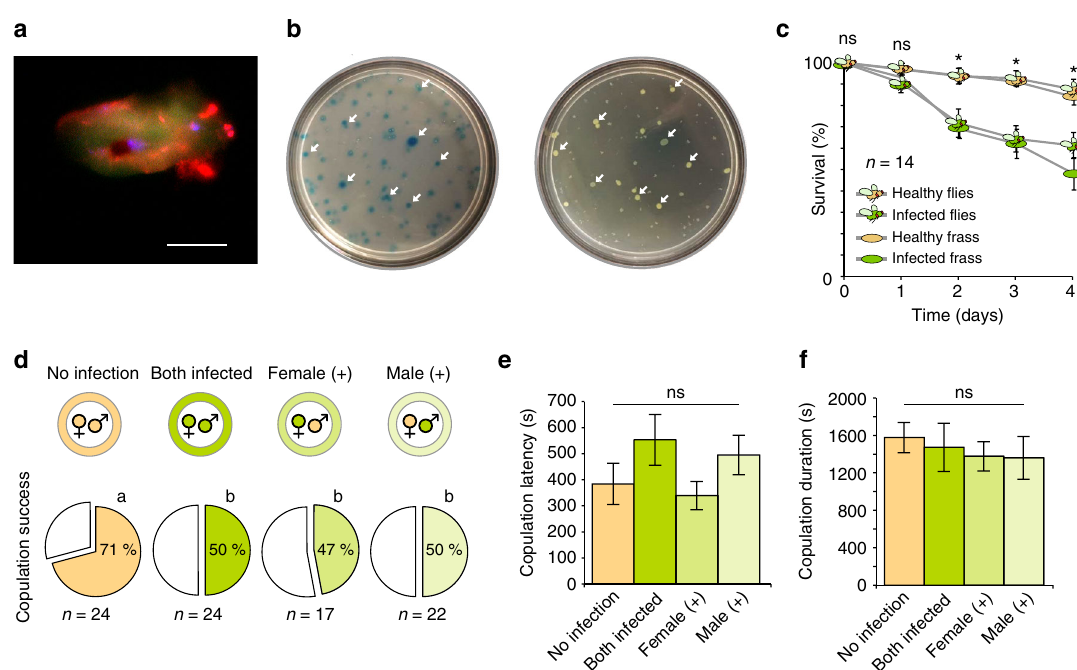
Fig. 3 Ecological impact of preference for infected fl ies and frass. a Frass droplet from a fl y that was fed green fl uorescent protein (GFP)-labeled bacteria, showing live bacteria ( green ) and dead bacteria ( red ) present in the feces. Scale bar depicts 10 µ m. b Flies fed with a solution containing bacteria and blue dye were allowed to deposit frass onto an agar plate ( left ), and bacterial colony growth was assessed from the fecal deposits ( right ), demonstrating that bacteria can survive the digestive tract and be transferred via feces to new locations. c Survival over time of cohorts of fl ies reared in containers that held either healthy or infected fl y adults or their frass (see Supplementary Fig. 5). d – f Copulation success ( d ), latency ( e ), and duration ( f ) of single pairs of fl